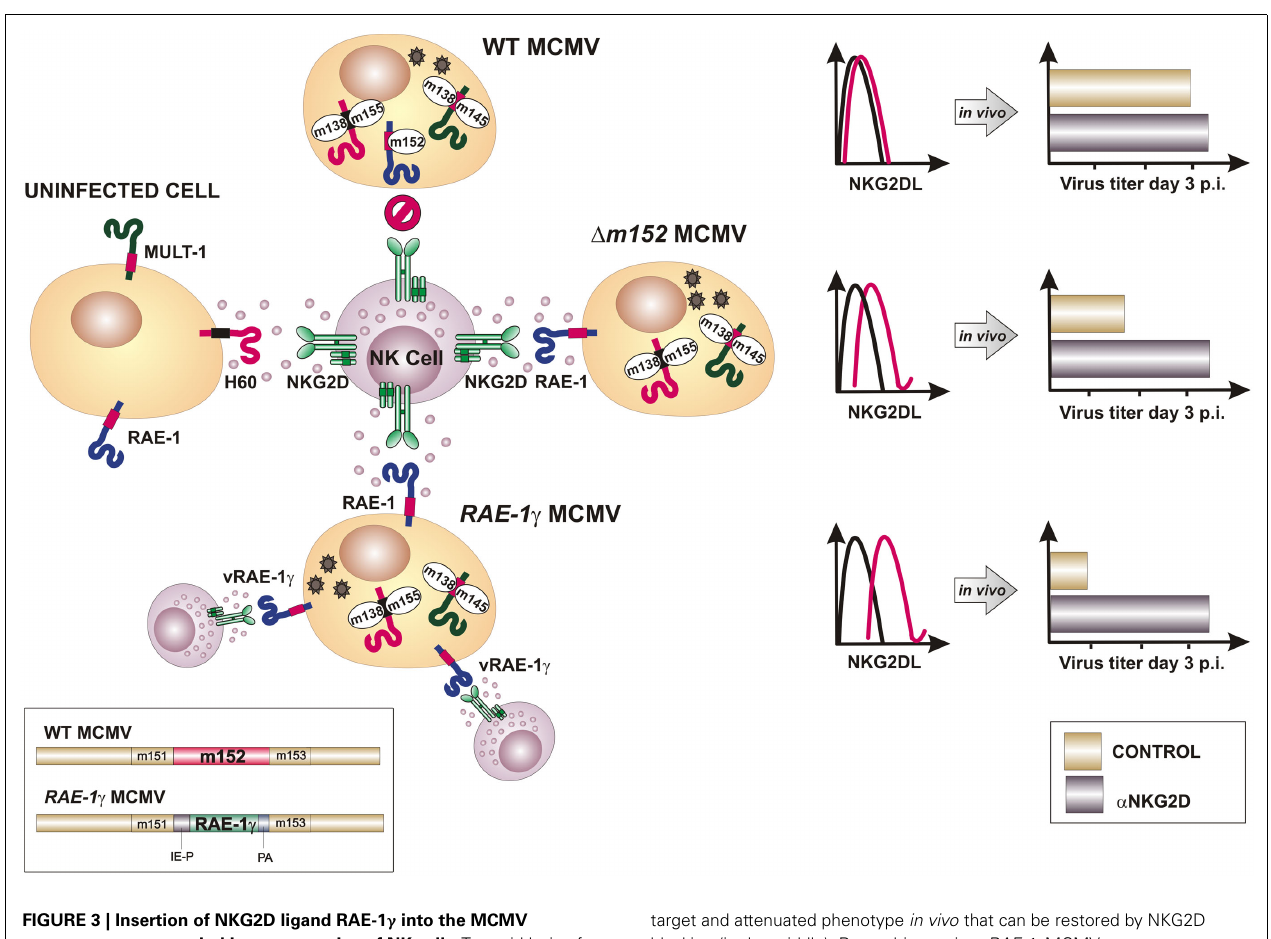
FIGURE 3 | Insertion of NKG2D ligand RAE-1 γ into the MCMV genome overcomes viral immunoevasins of NK cells. To avoid lysis of infected cell by the NK cells, MCMV encodes four immunoevasins (m138, m145, m152, and m155) that downmodulate cell surface expression of mouse NKG2D ligands. Consequently, blocking of NKG2D has little or no effect on virus growth in vivo (upper part). Deletion of either of NKG2D immunoevasins from the MCMV genome (e.g., m152 ) results in the reconstitution of the surface expression of its respective